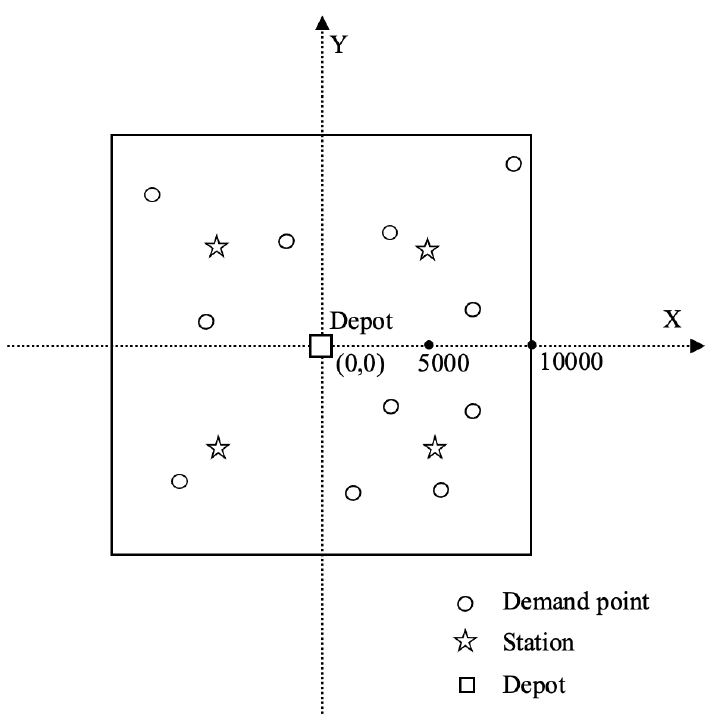
Figure 2. Schematic diagram of test area.